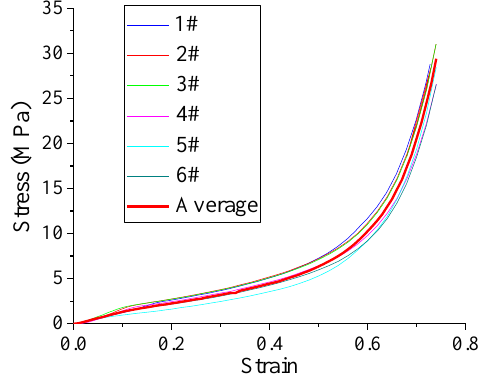
Figure 3. The stress-strain relationship of polyurethane elastomer in the test.